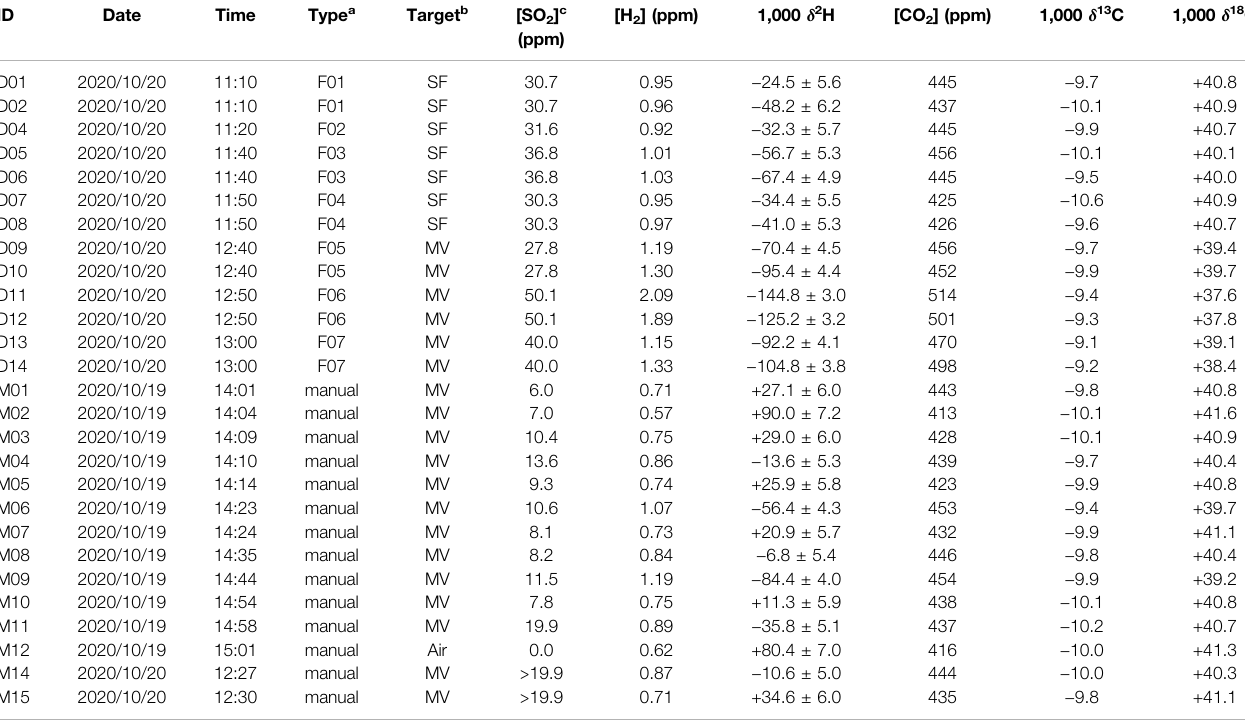
TABLE 1 | List of samples analyzed in this study, along with the concentration of SO 2 , concentration and isotopic compositions of H 2 , and concentration and isotopic compositions of CO 2 in the